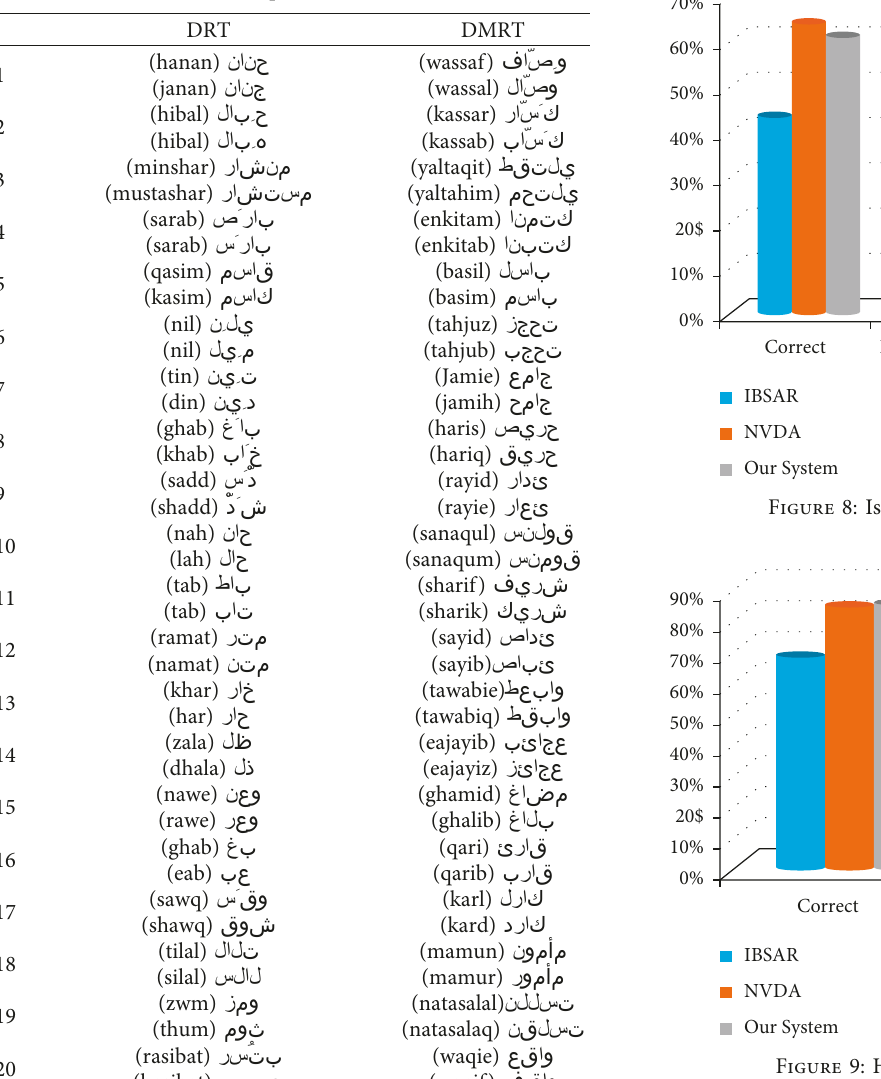
Table 4: Word lists for experiment 2 (DRT and DMRT).